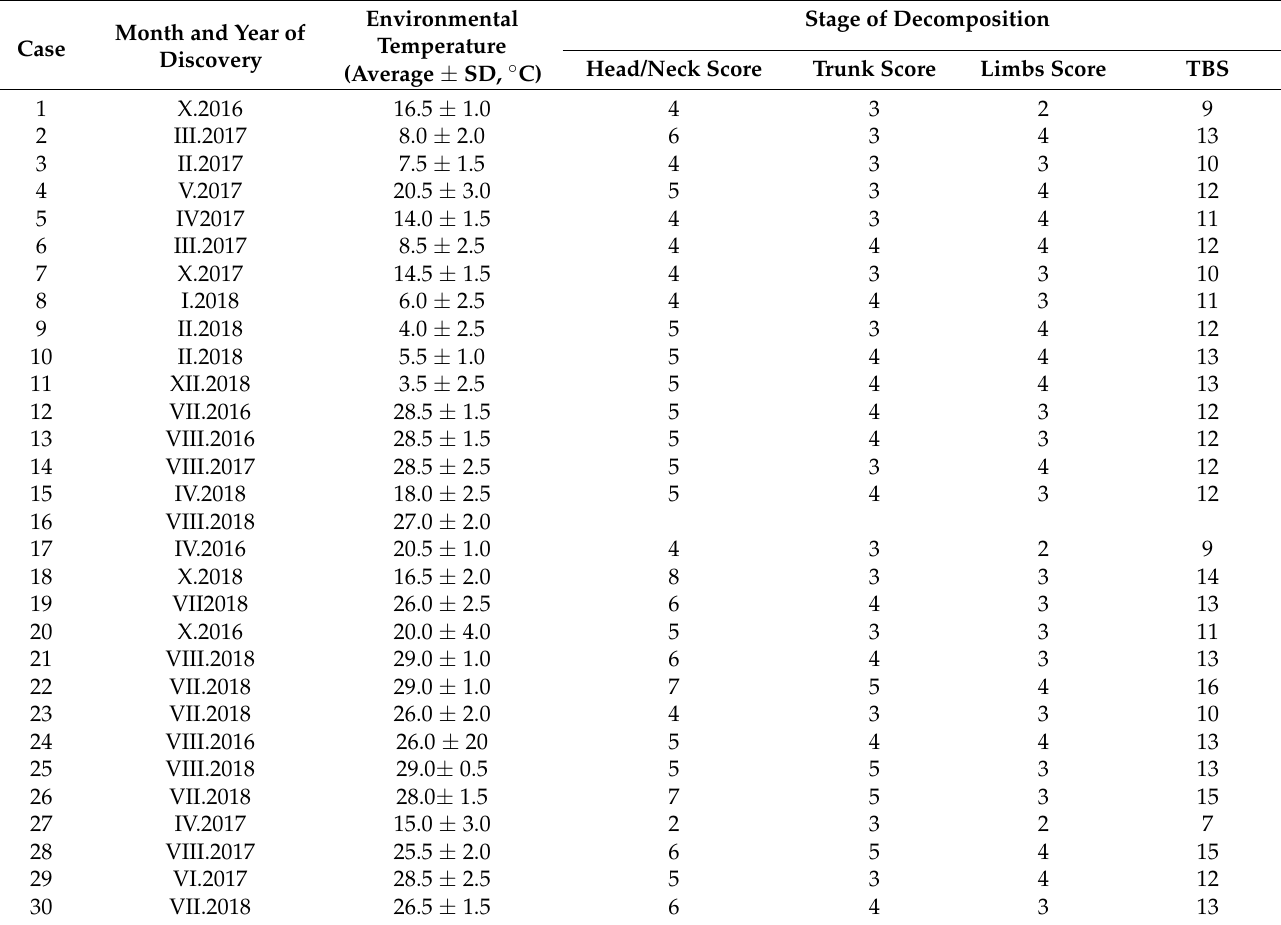
Table 1. Summary of the circumstantial, environmental temperature and stage of decomposition for each case (TBS: Total Body Score).